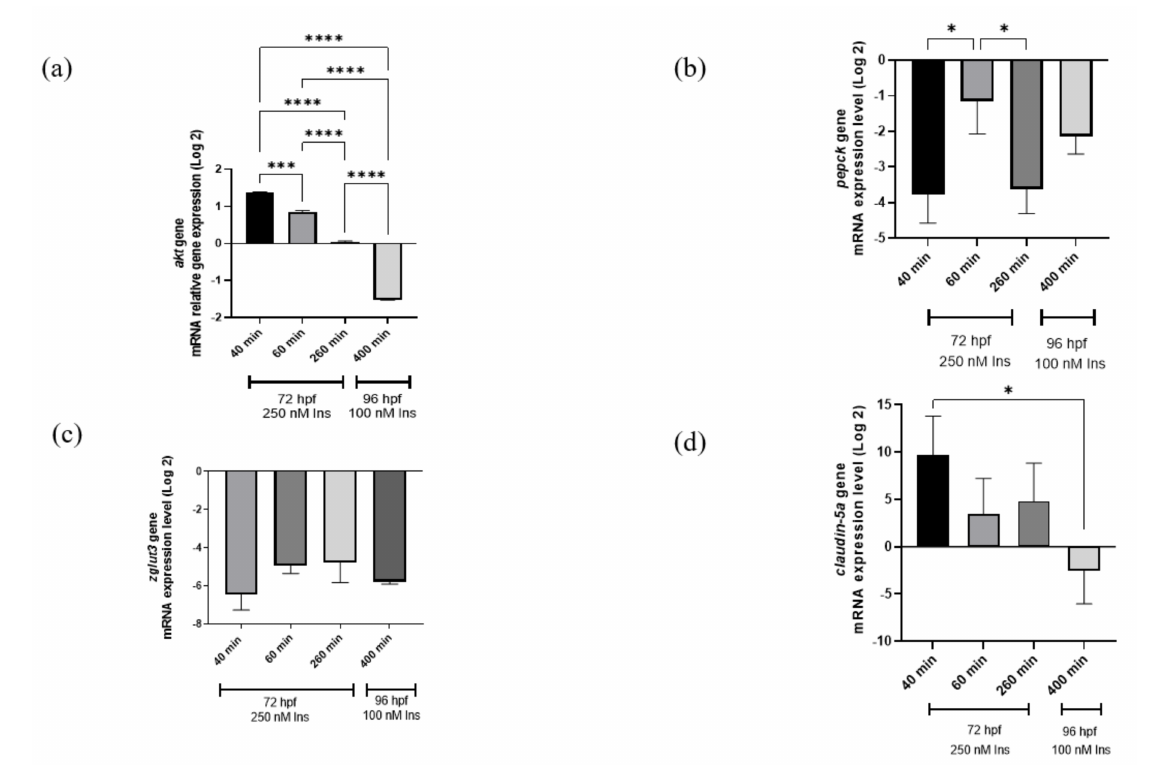
Figure 2. qRT-PCR analysis for insulin resistance model validation with ( a ) akt , ( b ) pepck , ( c ) zglut3 , and ( d ) claudin-5a genes expression on the effects of high insulin induction for 250 nM at 72 hpf and re-challenging after 24 h with 100 nM insulin at 96 hpf. Beta-actin , a housekeeping gene, was used for normalization. Data represent the mean ± SEM; n = 3 independent replicates with 20 larvae in each replicate. Statistical significance, as analyzed by One-way ANOVA with Tukey multiple comparison groups test, is expressed as (*) p < 0.05, (***) p < 0.001 and (****) p <